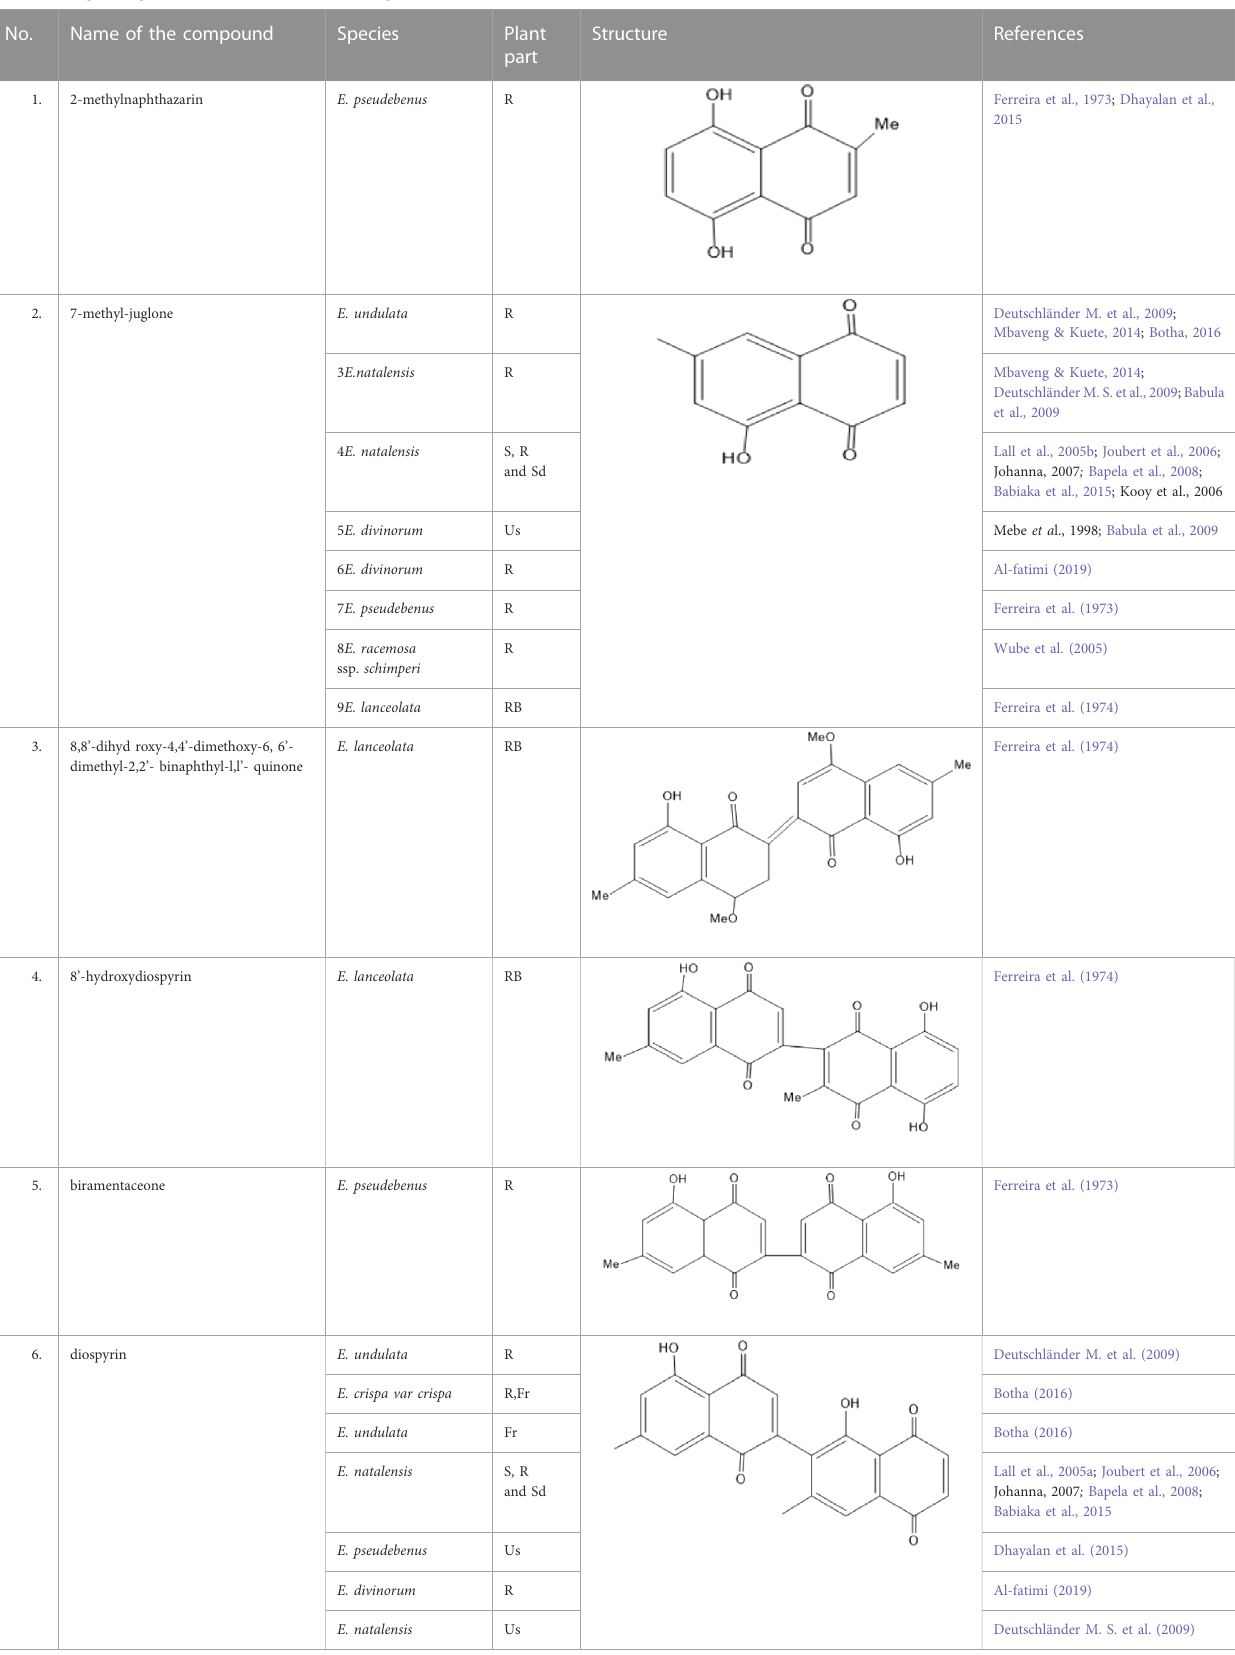
TABLE 2 Naphthoquinones isolated from Euclea species.